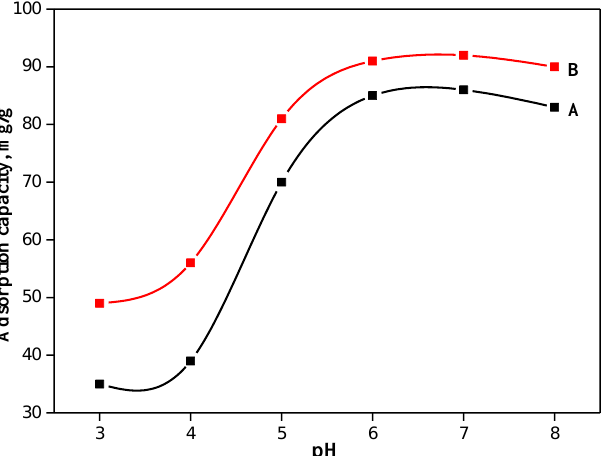
Figure 3. SEM images ( A – C ); EDX spectra ( D ) and TEM images ( E , F ) for TOCNF1 ( A , E ) and modified TOCNF2 ( B – F ).